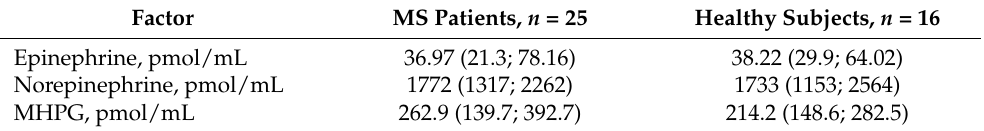
Table 3. The concentration of epinephrine, norepinephrine, and its metabolite MHPG in blood plasma (HPLC) in MS patients and in healthy subjects. Data are medians (25th and 75th percentiles). Factor MS Patients, n = 25 Healthy Subjects, n = 16 Epinephrine, pmol/mL 36.97 (21.3; 78.16) 38.22 (29.9; 64.02) Norepinephrine, pmol/mL 1772 (1317; 2262) 1733 (1153; 2564) MHPG, pmol/mL 262.9 (139.7; 392.7) 214.2 (148.6;